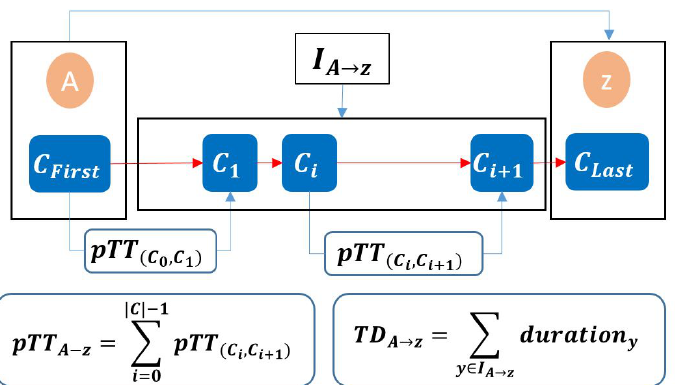
Figure 15. Predicted travel time and time spent on the intermediate activities: the sum of the travel time from A to z is the predicted travel time pTT A → z , and the sum of duration of the intermediate activities from A to z is the time spent TD A → z